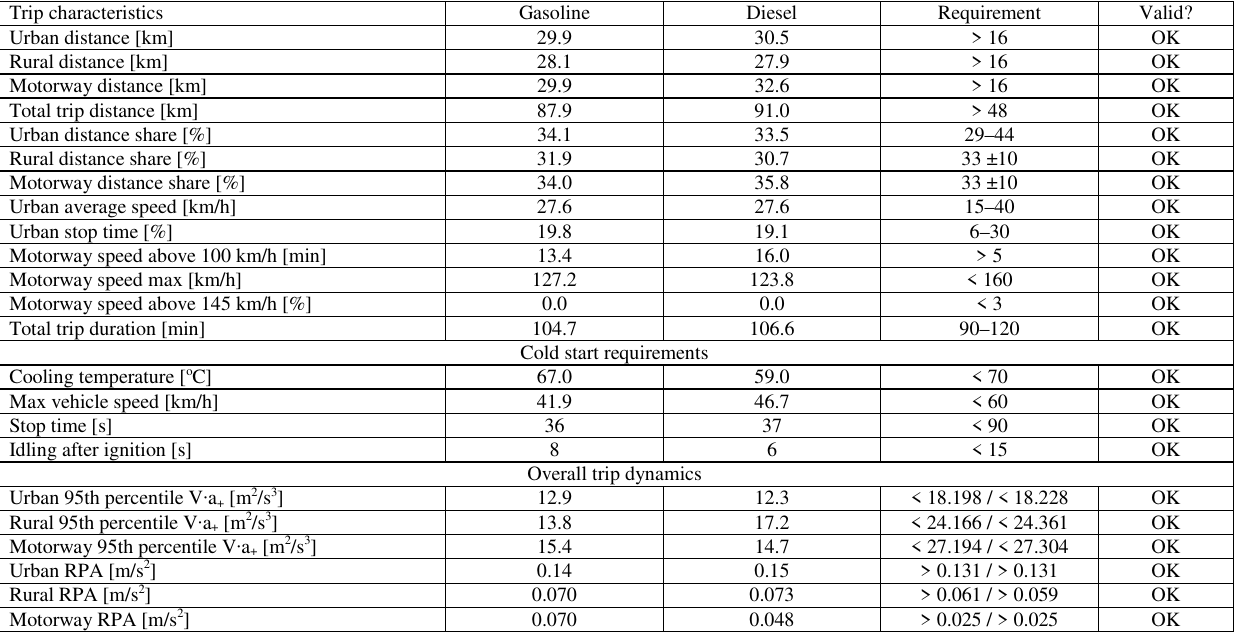
Fig. 5. The characteristics of vehicle operating time share in the velocity– acceleration co-ordinates for gasoline engine (a) and diesel engine (b) Table 1. Validation of trip characteristics in accordance with EU RDE